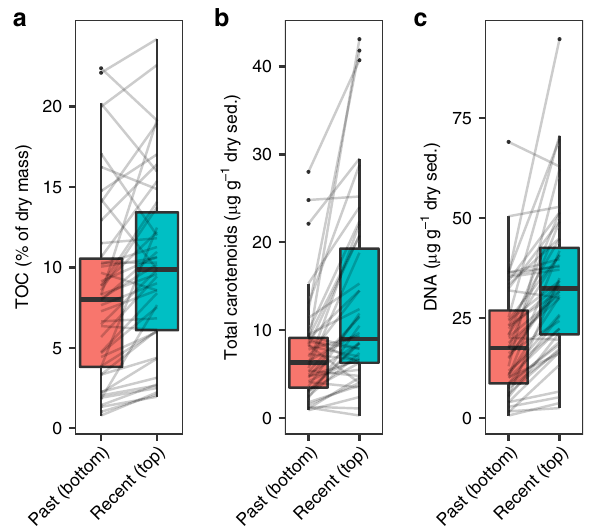
Fig. 1 Differences between the recent (top) and past (bottom) sediment strata. a Proportion of total organic carbon (TOC) in dry sediments ( n = 46 lakes), b concentrations of total carotenoid pigments expressed in µ g per g of dry sediment ( n = 44 lakes) and c concentrations of DNA expressed in µ g per g of dry sediment in the recent (top) and past (bottom) strata ( n = 48 lakes) of the sediment cores. Boxplots depict medians, fi rst and third quartiles, and full ranges (bounded at 1.5 × interquartile range). Gray lines connect values from the same lake.